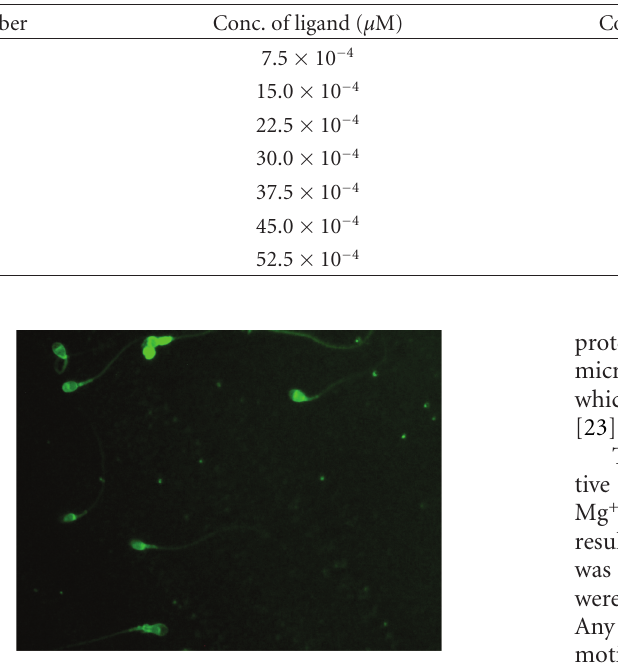
Figure 2: Fluorescent microscopy of human spermatozoa incu- bated with FITC labelled SIF